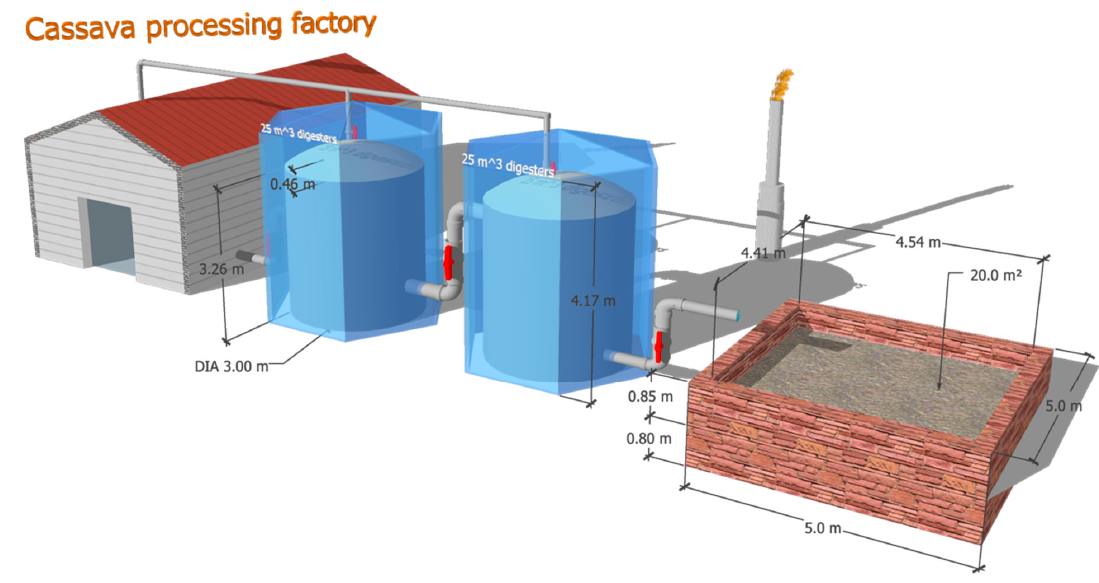
Figure 3. Scale-up model for a cassava processing factory, with two 25 m 3 digesters plumbed in